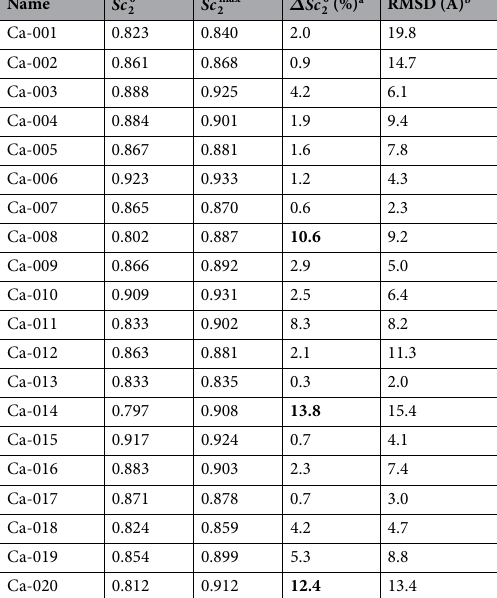
Table 1. Summary of analysis of integrins in Ca 2 + solution using X-ray crystal structure and best-fitting atomic models. a  − Sc Sc Sc ( ) 2max 20 20 . Values larger than 10 are written in bold. b RMSD of best-fitting atomic model from X-ray crystal structure.